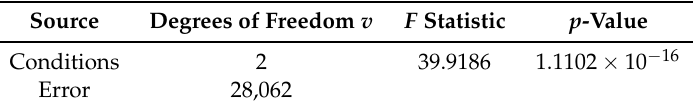
Table 2. ANOVA results.